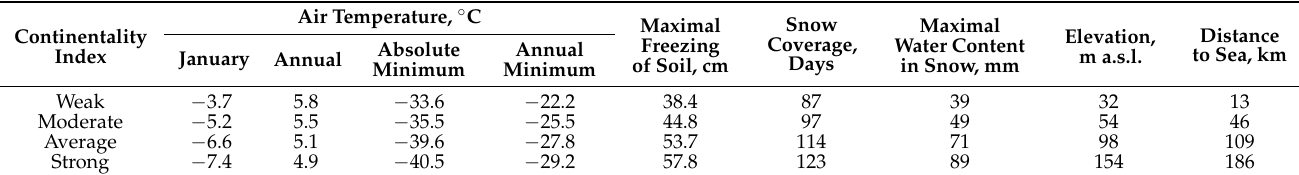
Table 3. Continentality index characteristics for the territory of Latvia after